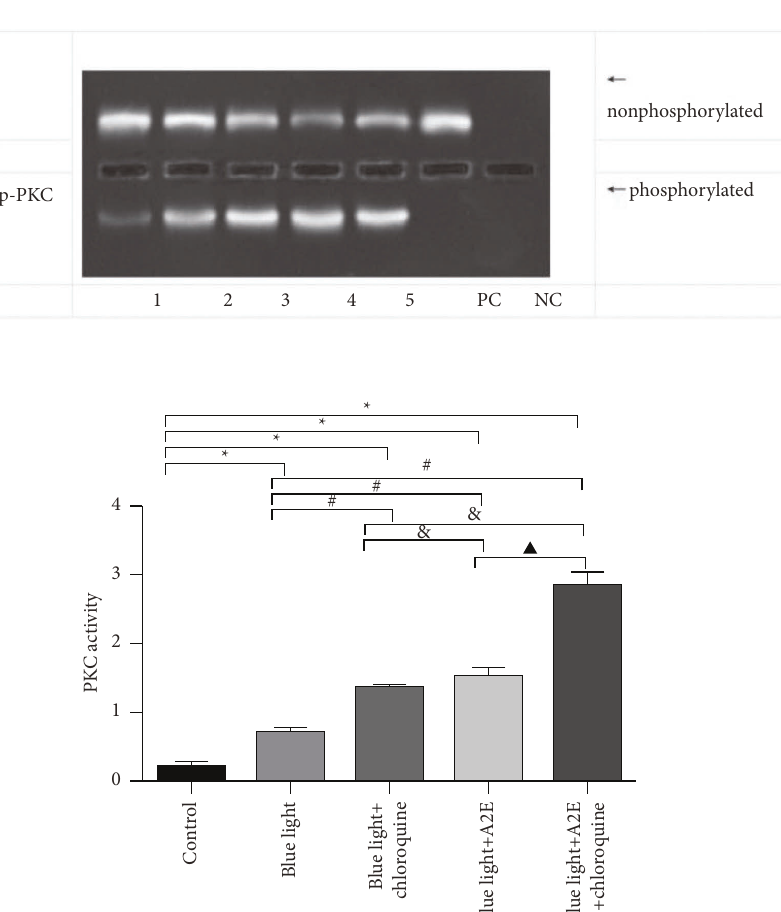
Figure 4: Changes in PKC activity in RPE cells, as shown by agarose gel electrophoresis. The ratio of the gray value of phosphorylated PKC and that of nonphosphorylated PKC indicated PKC activity. The data are presented as the mean ± SD ( n � 3). An LSD test was conducted following one-way ANOVA. ∗ P < 0 . 05 vs. control cells; # P < 0 . 05 vs. blue light-treated cells; & P < 0 . 05 vs. blue light+chloroquine-treated cells; ▲ P < 0 . 05 vs. blue light +A2E-treated